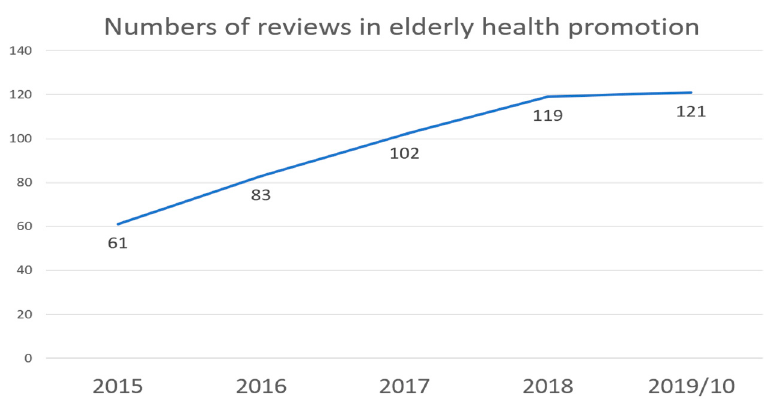
Figure 2. Number of reviews from 2015 to 10 October 2019.